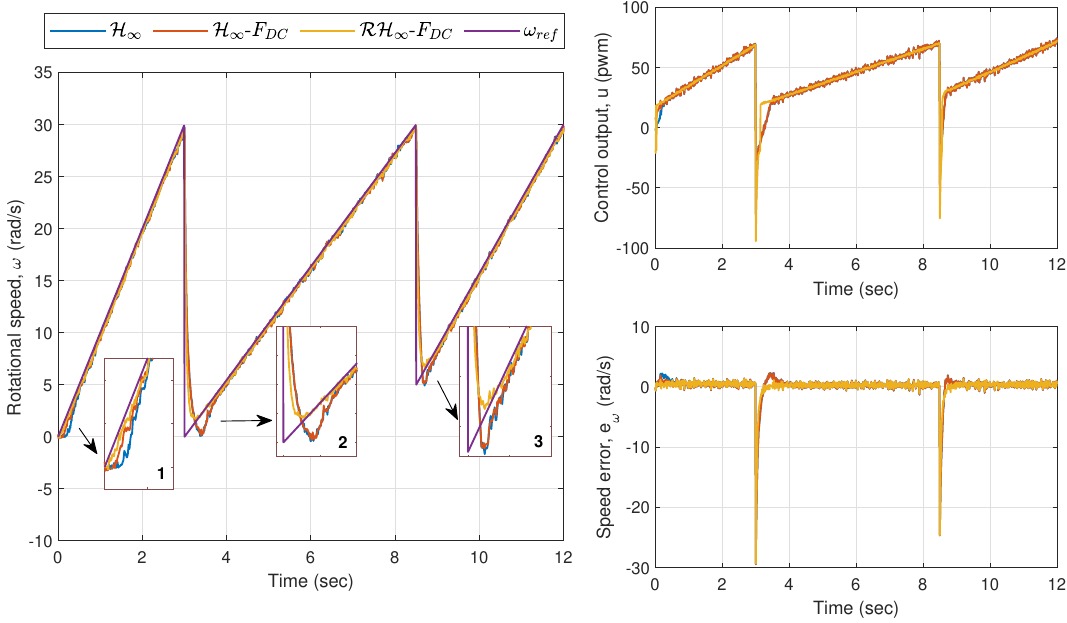
Figure 10. Exp. 1.2: Time responses of Motor A for a changing ramp input. Longer delays and big overshoot can be observed when H ∞ and H ∞ - F DC are applied.